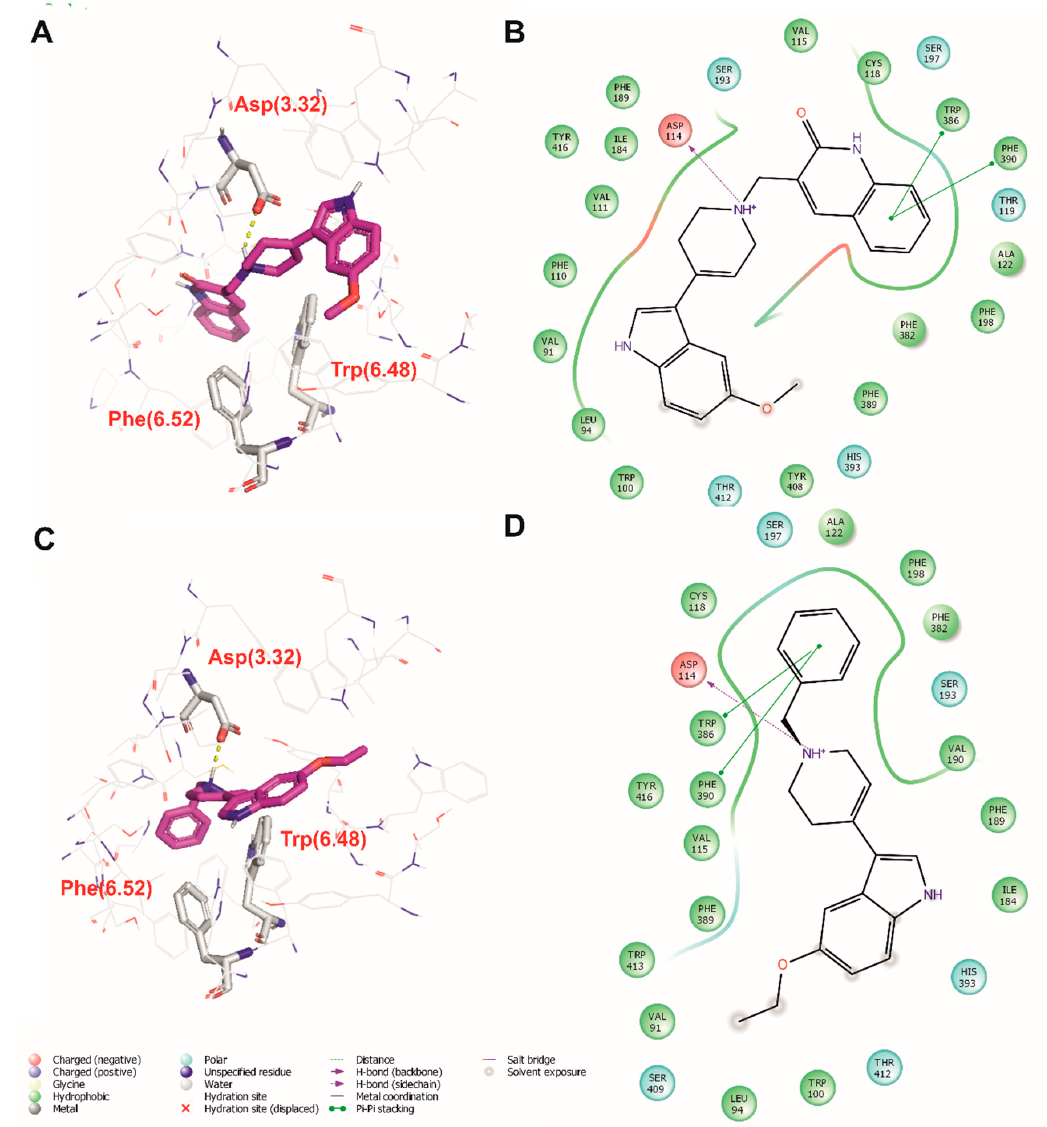
Figure 5. The lead structure D2AAK1 ( A , B ) and its derivative D2AAK1_3 ( C , D ) in the binding pocket of human dopamine D 2 receptor. ( A , C ) 3D view of the binding site. Ligands represented as sticks with magenta carbon atoms. Protein represented as wire with grey carbon atoms, main interacting residues shown as sticks. Hydrogen bonds shown as yellow dashed lines. Non-polar hydrogen atoms not shown for clarity. ( B , D ) 2D view of the binding site.